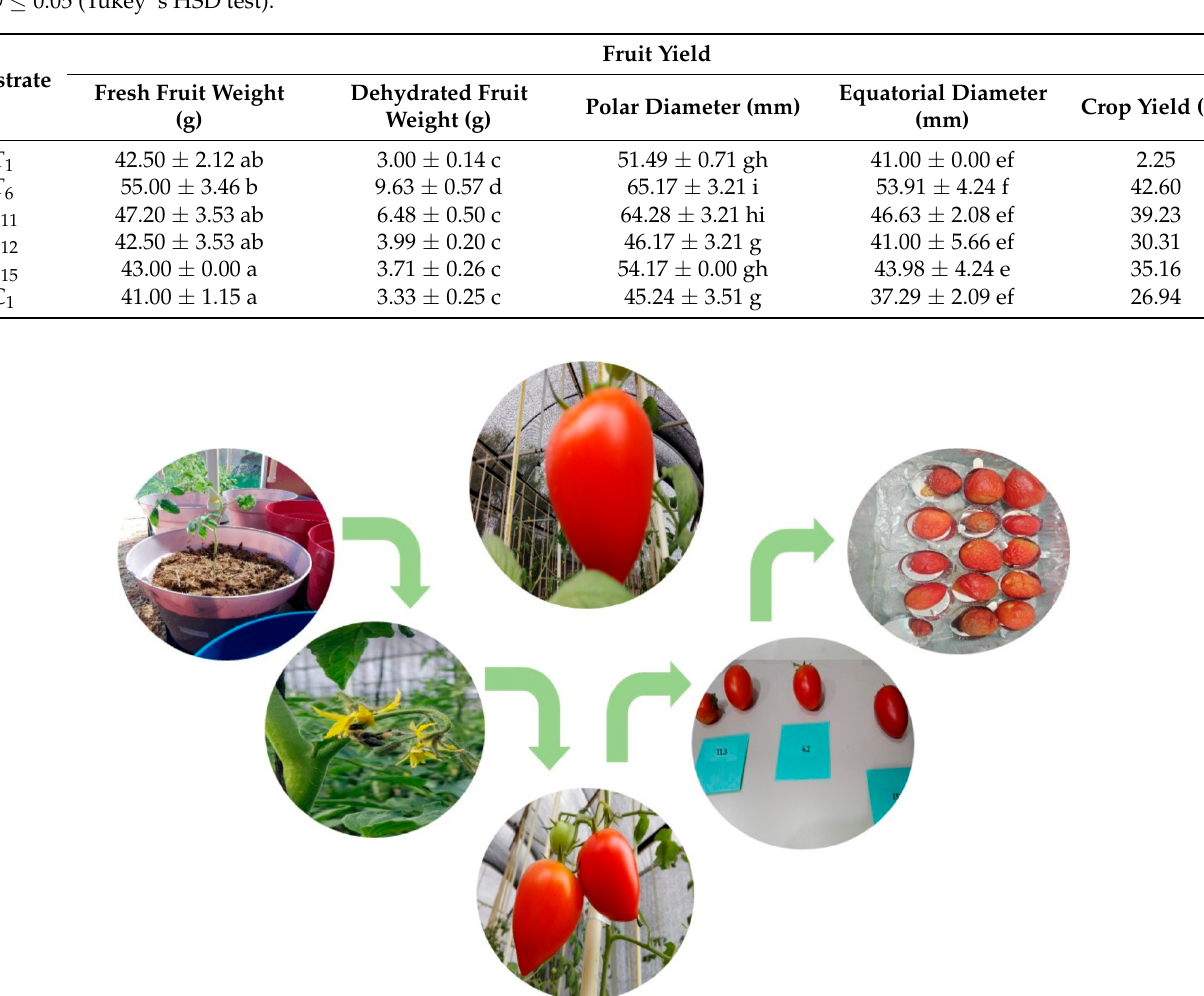
Figure 4. Evolution of the tomato plant growth emphasizing the specimens during the measurement of fresh weight, dry weight, polar diameter, and equatorial diameter after the harvesting stage (130 DAT).